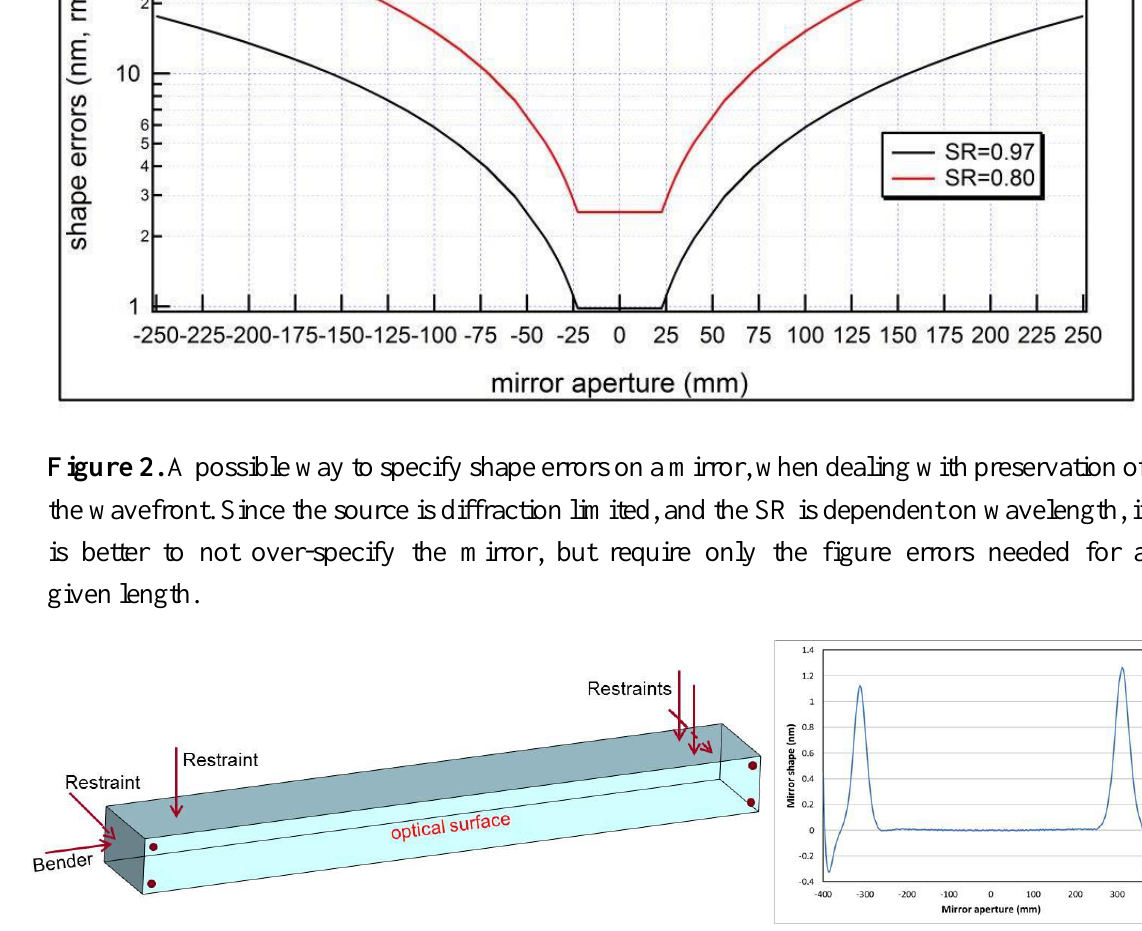
Figure 3. A schematic illustration ( left ) of how a mirror holder should be made for a horizontally deflecting mirror. All of the restraints must be as far as possible from the central part of the mirrors to avoid induce of deformation where the most demanding shape errors are required. The right panel shows the calculated induced deformation for such a holder on a 1 m long silicon